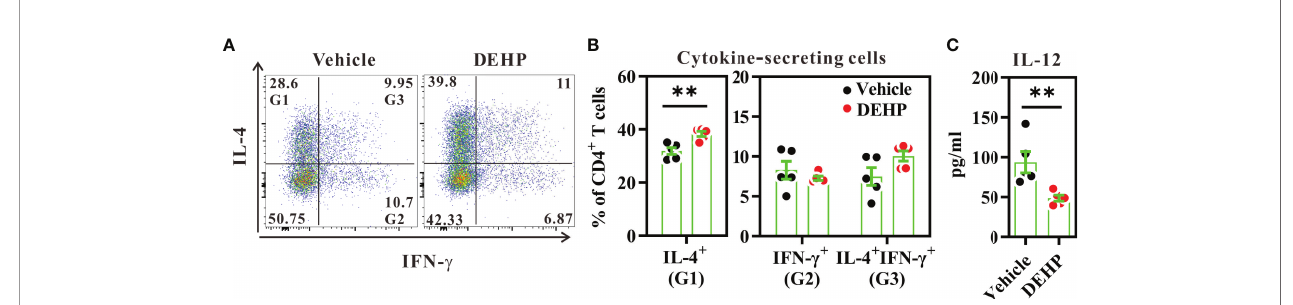
FIGURE 2 | Analysis of cDC function in spleens. BALB/c mice were given oral DEHP, at a dosage of 37 m g/kg BW/day, or 0.33% ethanol in corn oil as vehicle, for 10 d. Puri fi ed splenic cDCs from treated mice were co-cultured with naïve CD4 + T cells in the presence of anti-CD3 monoclonal antibody for 5 d. (A) Representative dot plots show cytokine-secreting cells gated from viable CD4 + T cells. (B) The percentages of cytokine-secreting cells in individual samples from both groups. (C) IL-12 level in CpG1826-stimulated splenic cDCs from treated mice, as analyzed using ELISA. n=5 in each group. Data are representative of two independent experiments. Results are shown as mean ± SEM. **P < 0.01, as assessed using Mann – Whitney U